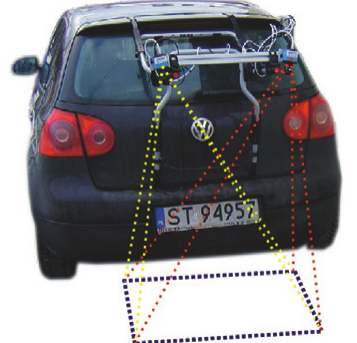
Fig. 3. Measurement vehicle with the stereo vision